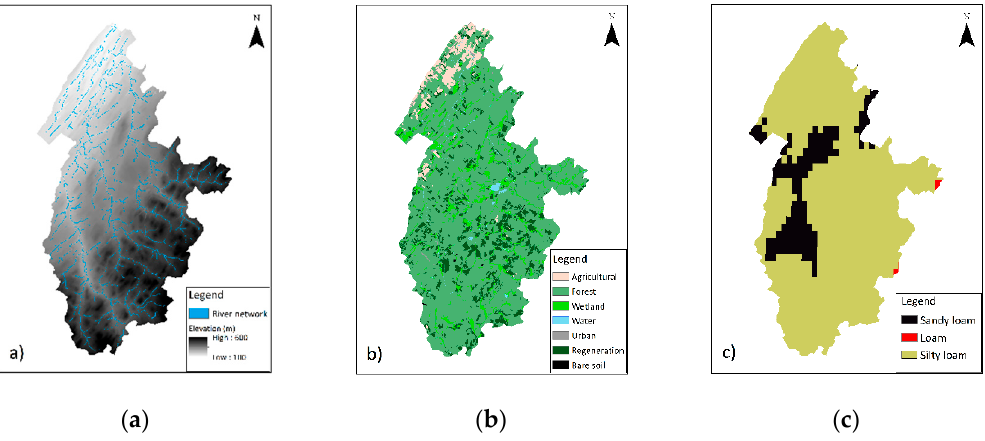
Figure 4. Du Loup River catchment (515 km 2 ). ( a ) Topography and river network, ( b ) land uses, and ( c ) soil